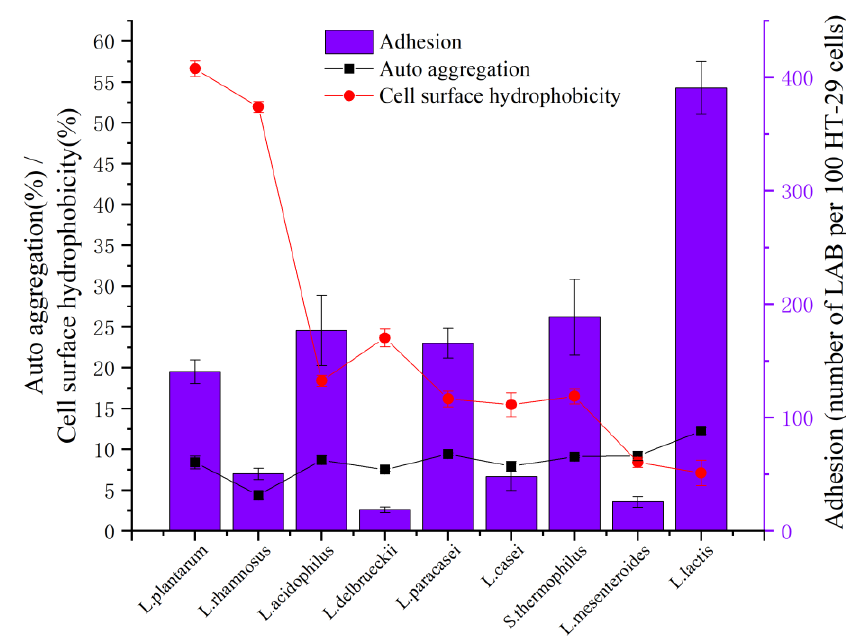
Figure 2. Cell adhesion ability of